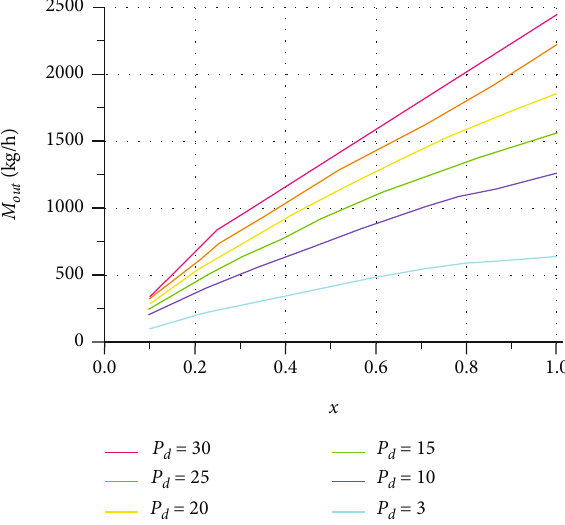
and relative valve out